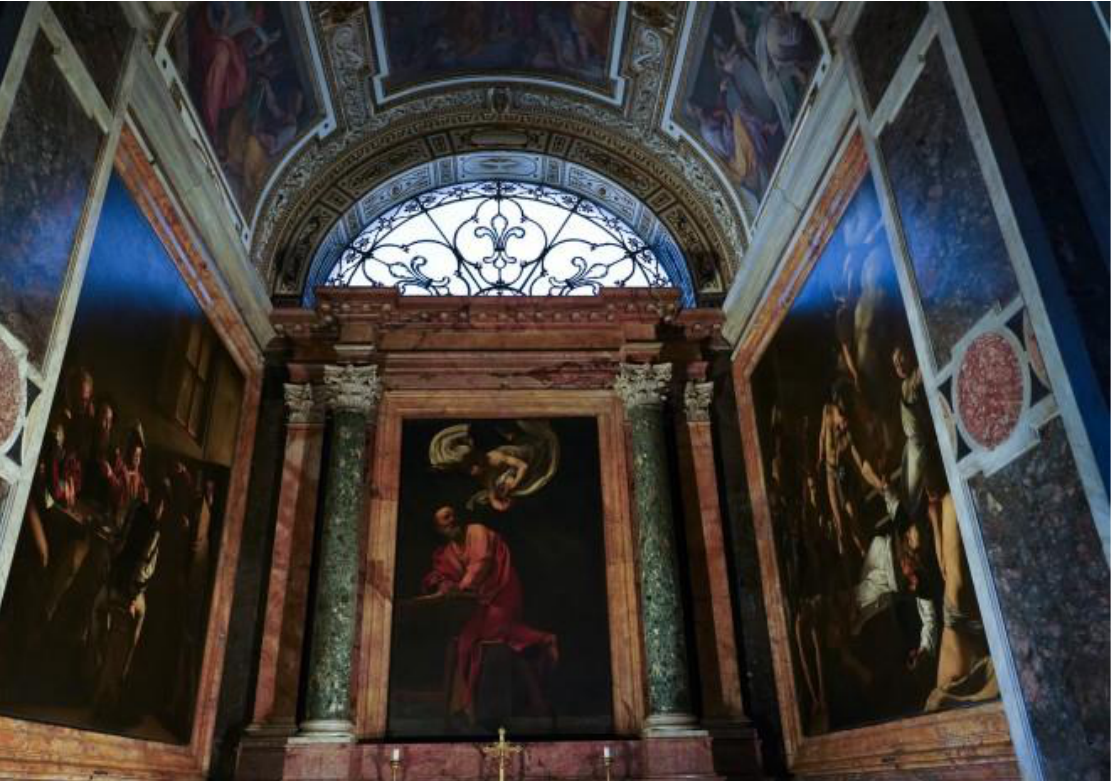
Figure 2. Christ Crucified, Diego Rodríguez de Silva y Velázquez, 1632. Photo: Bernardo Pérez, public domain. From El País , 31 Janvier 2013, “Velázquez made in China” . Chinese artists came to the museum to copy masterpieces of its collection. The copies were subsequently put on a show in Beijing. On the photo is “ Li Wendong, de 40 años, entró por primera vez al Prado en 2004. Desde entonces admiró “ El Cristo ” de Velázquez”. (https://elpais.com/cultura/2013/01/27/album/1359245069_373345.html#foto_gal_4). (accessed on 8 March 2022)